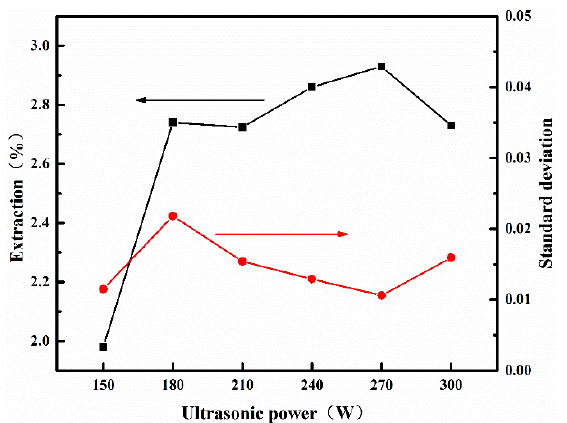
Figure 6. Effect of ultrasonic vibrator on extraction rate. ( The black arrow represents the extraction rate curve and the red arrow represents the standard deviation curve. )